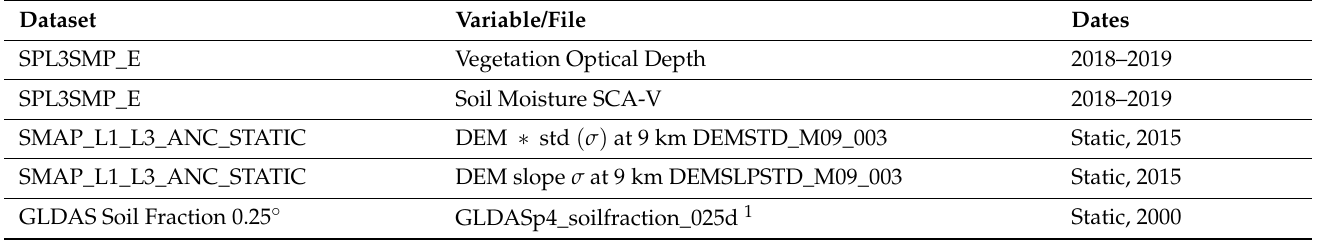
Table 1. Datasets used to evaluate SMAP-R